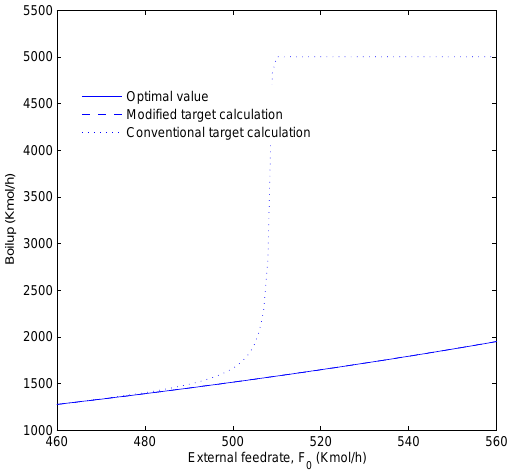
Figure 5: Column boilup V , as function of external fee- drate F 0